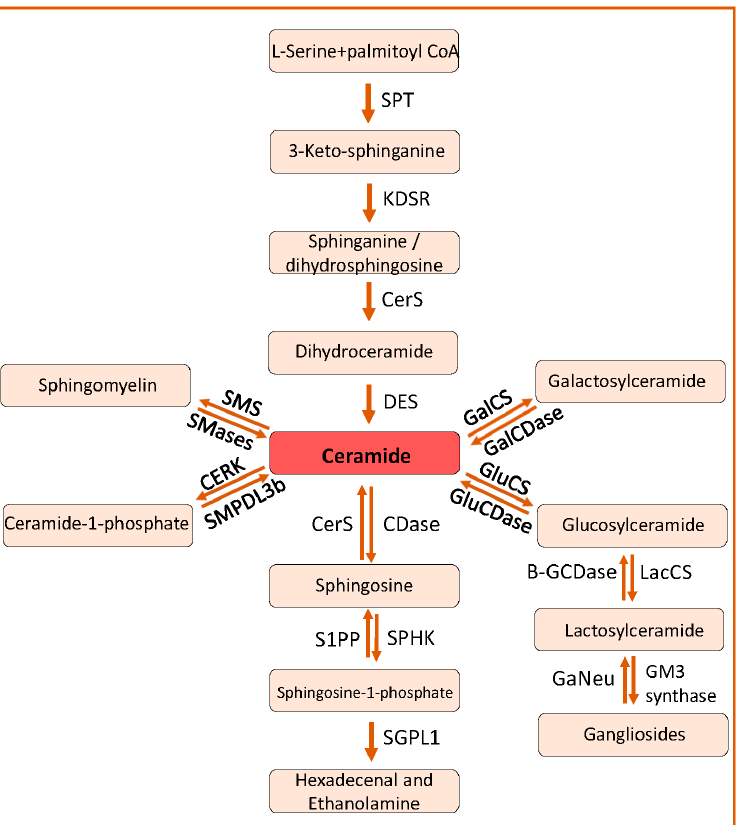
Figure 1. General structure of sphingolipids. Sphingosine is the backbone of the sphingolipid struc- ture that is linked to fatty acids by an amide bond. Depending on the type of residue in the side chain, sphingolipids are categorized as ceramides, sphingomyelins and glycosphingolipids.